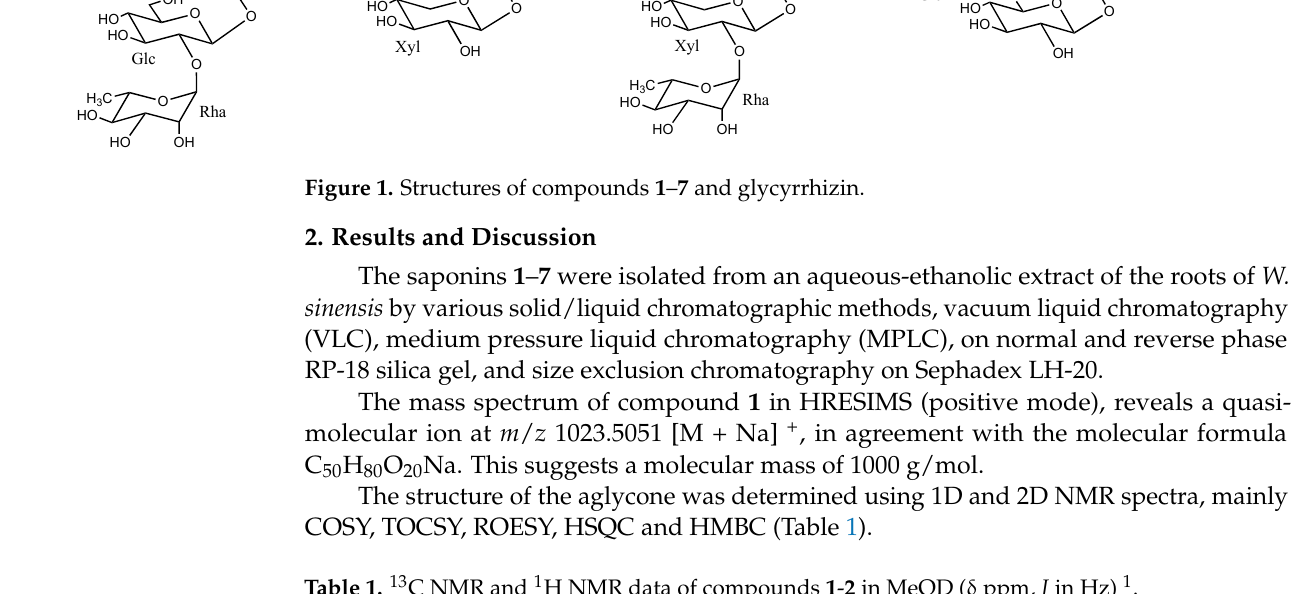
Table 1. 13 C NMR and 1 H NMR data of compounds 1 - 2 in MeOD ( δ ppm, J in Hz) 1